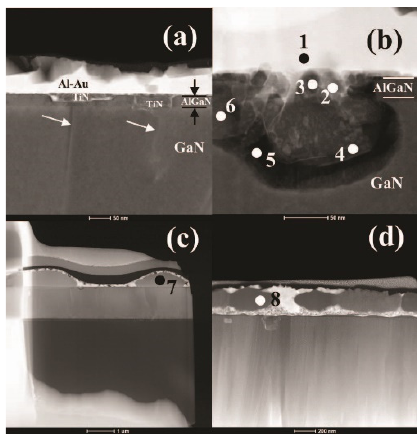
Figure 12. ( a ) TEM image of the post-annealing structure by MWA where the arrows markings indicate dislocations. ( b ) Magnified image of the interface. ( c ) TEM image of bulge area of the alloyed ohmic contact treated by RTA. ( d ) TEM image of bulge area of the alloyed ohmic contact treated by MWA. Reprinted with permission from Ref. [88]. Copyright 2015, IEEE. Table 4. EDS Composition (at. %) from the points labeled in Figure 12. Reprinted with permission from Ref. [88]. Copyright 2015, IEEE.